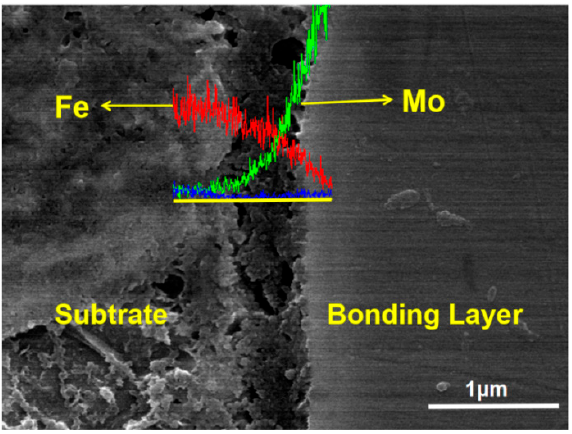
Figure 7. EDS line scan of bonding area between substrate and bonding layer.